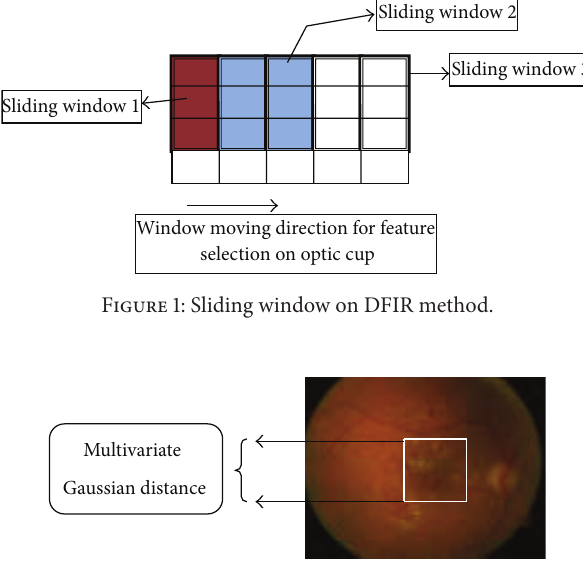
Figure 2: Distance computation on affected diseased optic cup.